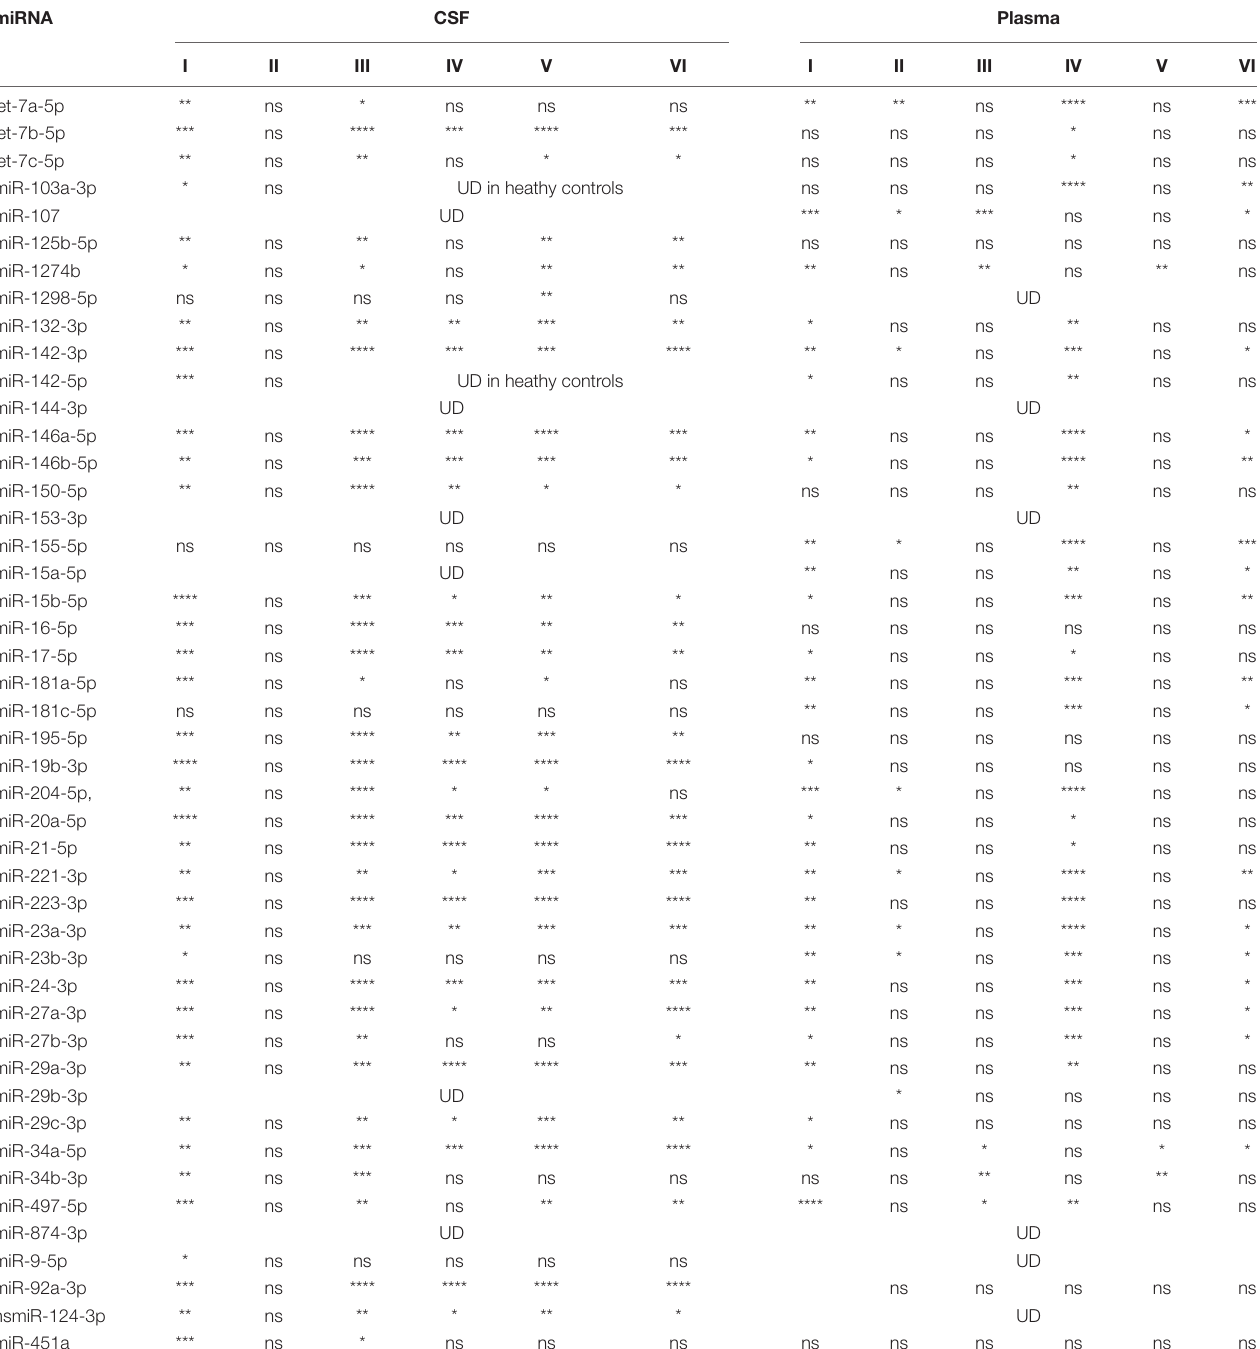
TABLE 3 | Significant differential expression levels of brain and vasculature injury related miRNAs.